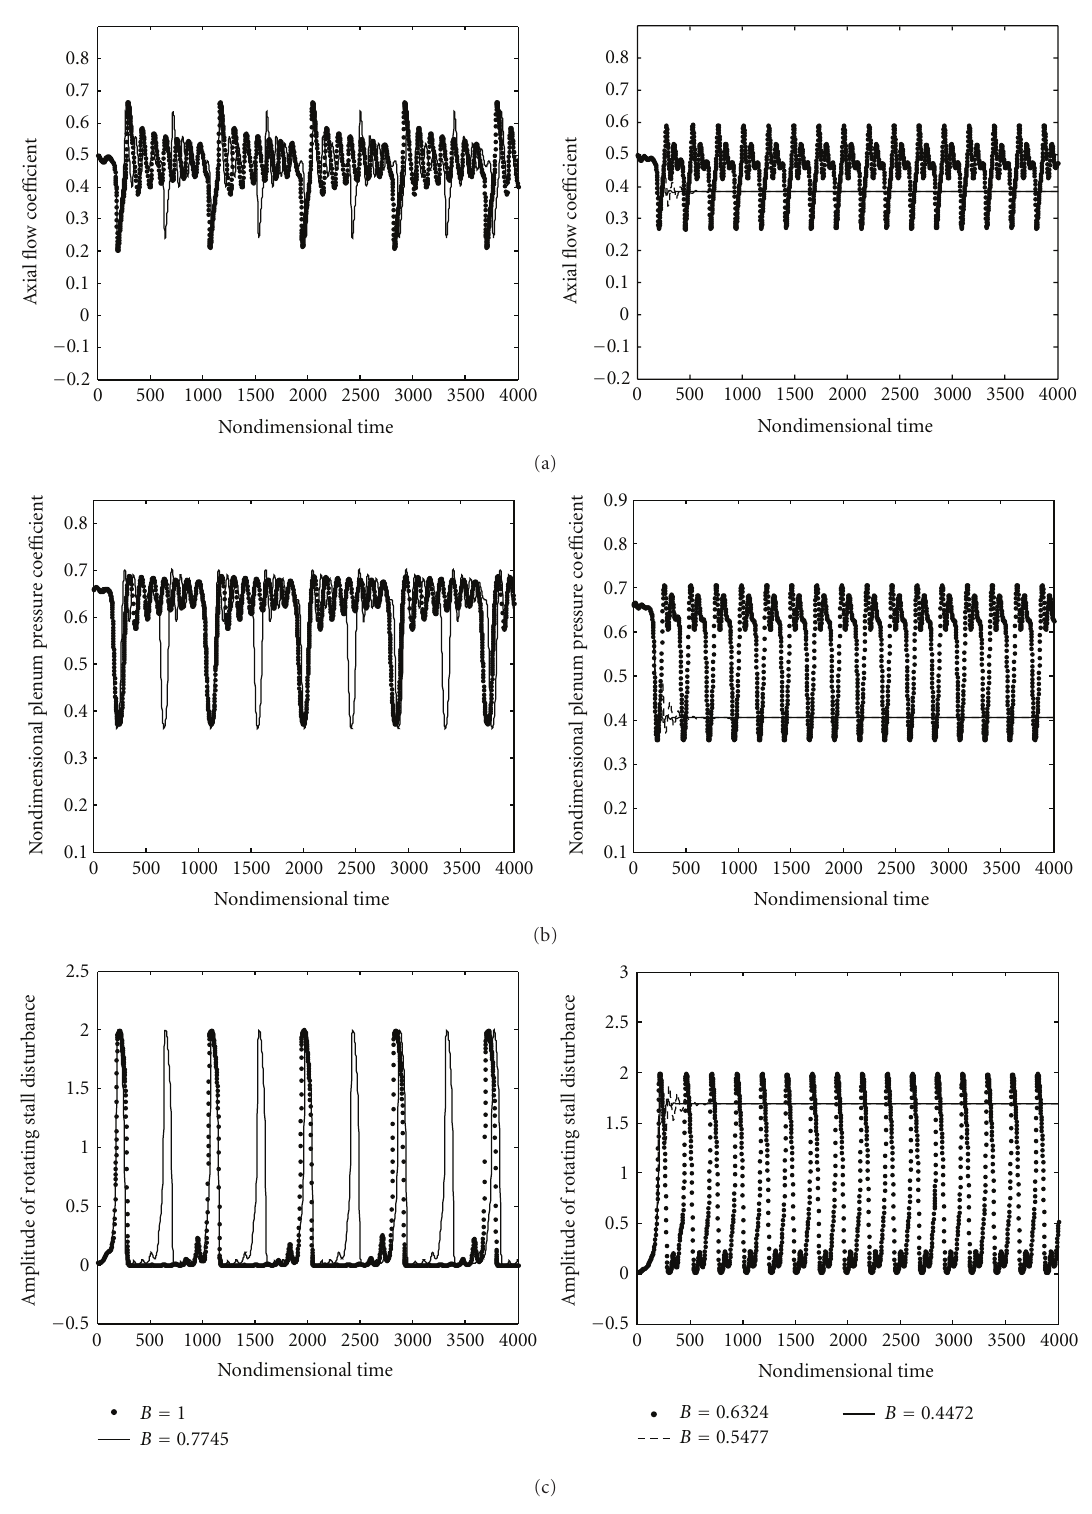
Figure 4: Temporal variation of nondimensional flow properties (a), (b), and (c) with decrease in size of plenum: (a) axial flow coe ffi cient, (b) plenum pressure rise coe ffi cient, and (c) disturbance amplitude of rotating